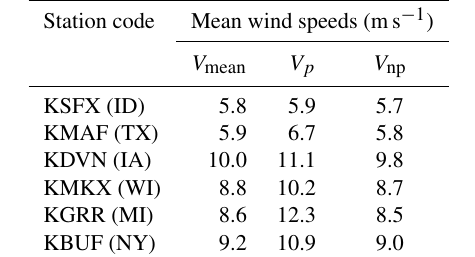
Table 2. Mean wind speeds close to WT HH from each radar: the long-term mean, V mean , the mean during times of precipitation, V p , and the mean during times of no precipitation V np